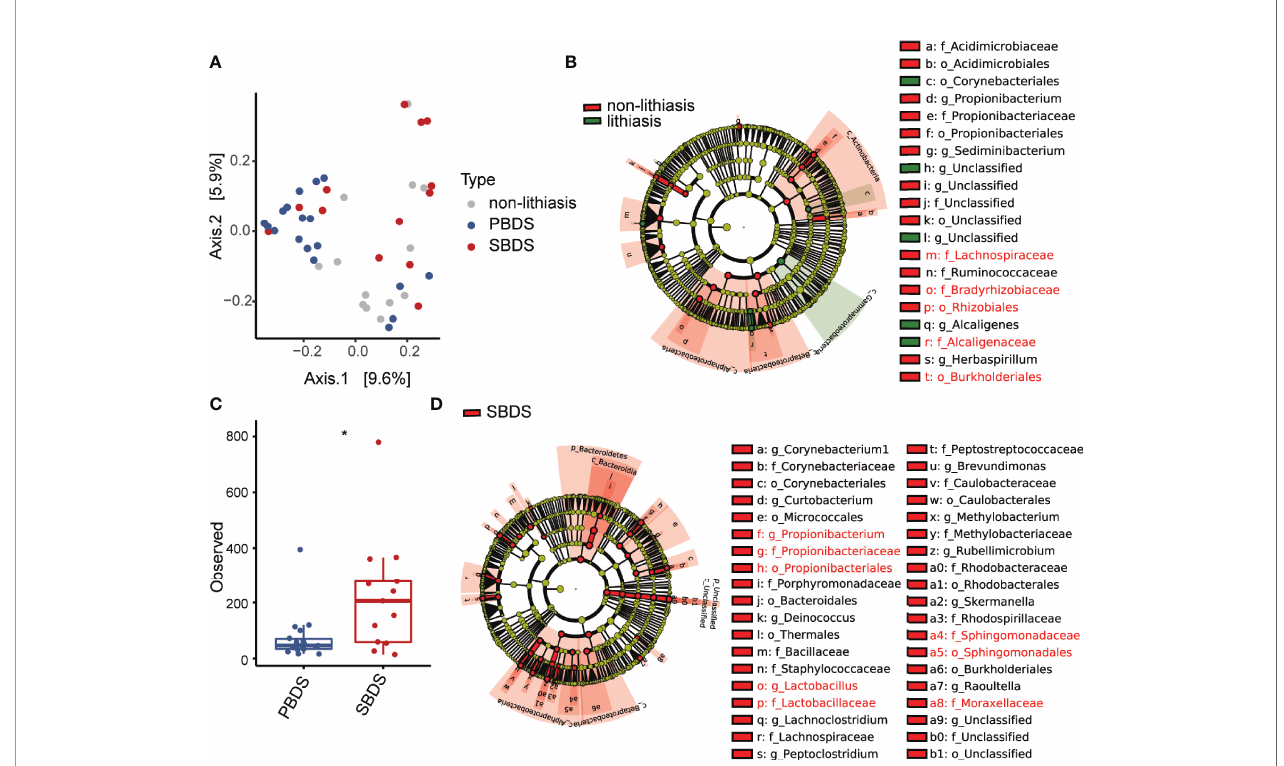
FIGURE 2 | Diversity and differential abundance analysis by 16S sequencing. (A) Beta diversity analysis presented as principal-coordinate analysis (PCoA) o unweighted Unifrac distances. (B) Thecladogram of taxonomic distribution of the lithiasis and non-lithiasis group, obtained by LEfSe with an LDA score threshold of > 3 ( a < 0.05), those validated by ALDEx2 are marked red (Wilcoxon test; p < 0.05). (C) Alpha diversity in the form of Shannon index compared between PBDS and SBDS (Wilcoxon test; *, FDR < 0.05). (D) LEfSe analysis between SBDS and PBDS, parameters are the same as for panel (B) , those validated by ALDEx2 are marked red (Wilcoxon test; p < 0.05). PBDS, primary bile duct stone; SBDS, secondary bile duct